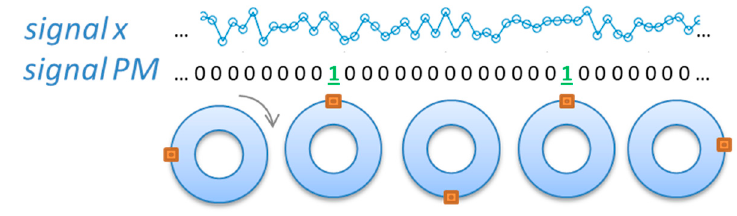
Figure 3. Idea of the 1-per-rotation PM signal.